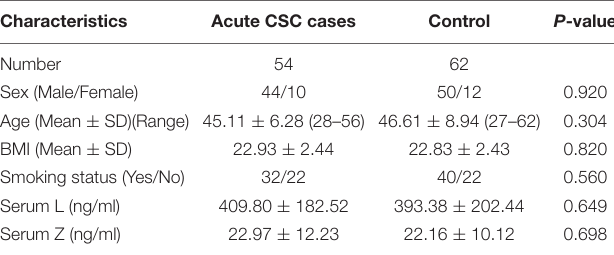
TABLE 1 | General characteristics and serum L/Z levels in all the participants.